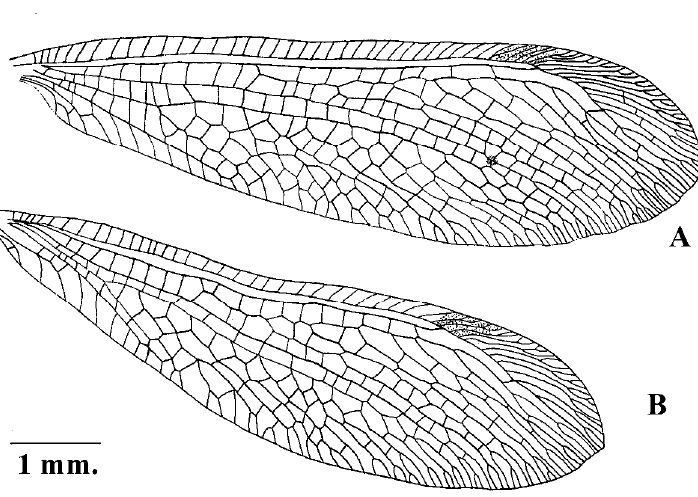
FIG . 6.- Wings of Cueta luteola ,A;fore wing,B: hind wing.